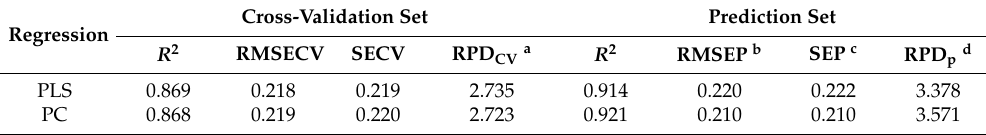
Table 3. Statistics of cross-validation and prediction set for piperine by PLS and PC regression.